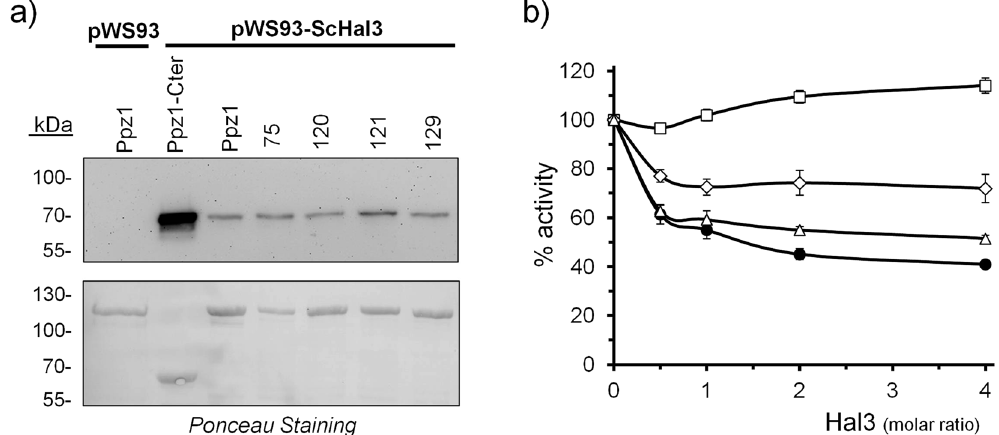
Figure 6. Hal3 binding capacity and inhibition profile of Ppz1 variants carrying two aminoacid mutations. ( a ) The indicated versions of GST-Ppz1 were immobilized on glutathione beads and processed as described in the legend of Fig. 4a. The upper panel reveals the amount of HA-tagged Hal3 bound to the phosphatase. The lower panel corresponds to the Ponceau-stained membranes, to show the amount of Ppz1. ( b ) Dephosphorylation assays were carried out as described in Fig. 3. Wild type Ppz1 (- ● -); clone 120 (- □ -); clone 121 (- ◊ -); clone 129 (- Δ -). Values are means ± S.E. for 6 to 10 different